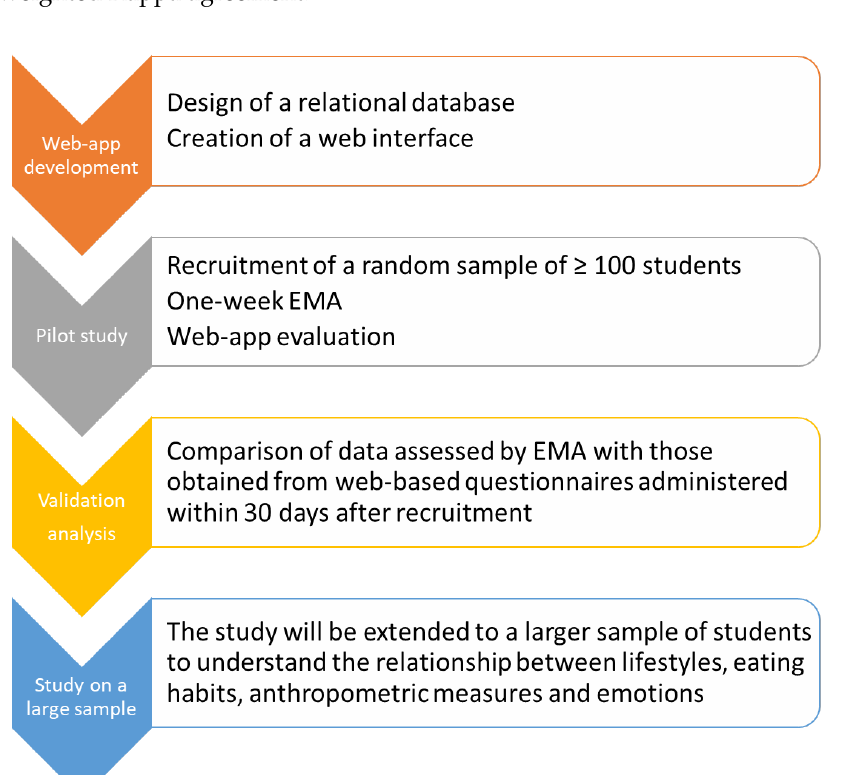
Figure 1. Summary of all phases of the HEALTHY-UNICT project.